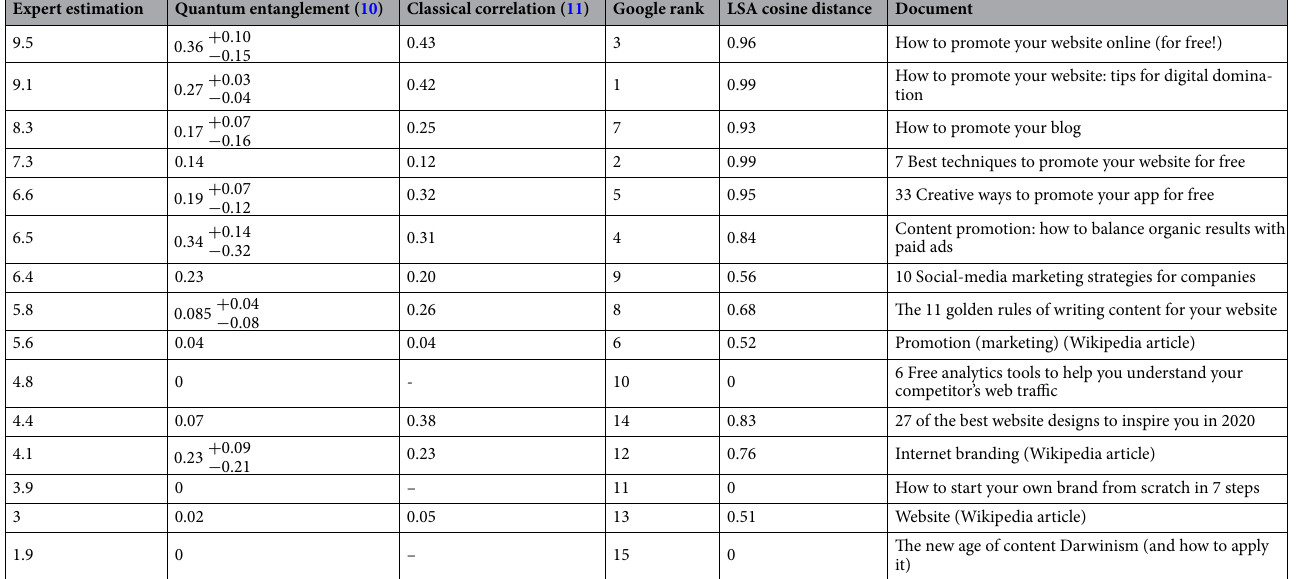
Table 2. Results of testing the quantum model of semantic connection between concepts website and promotion for 15 probe documents. Documents are listed in order of their mean ranking by experts according to how well they answer the question << What is website promotion? >> (column 1). Column 2 shows value of concurrence measure of semantic entanglement (10) between words website and (cid:31) ; for those documents where factor √ N 01 N 10 N 00 N 11 is nonzero, upper and promotion , randomized in lower bounds are shown. Columns 3–5 contain classical correlation (11), Google rank in response to the query website promotion and LSA cosine distance between the same words in 12